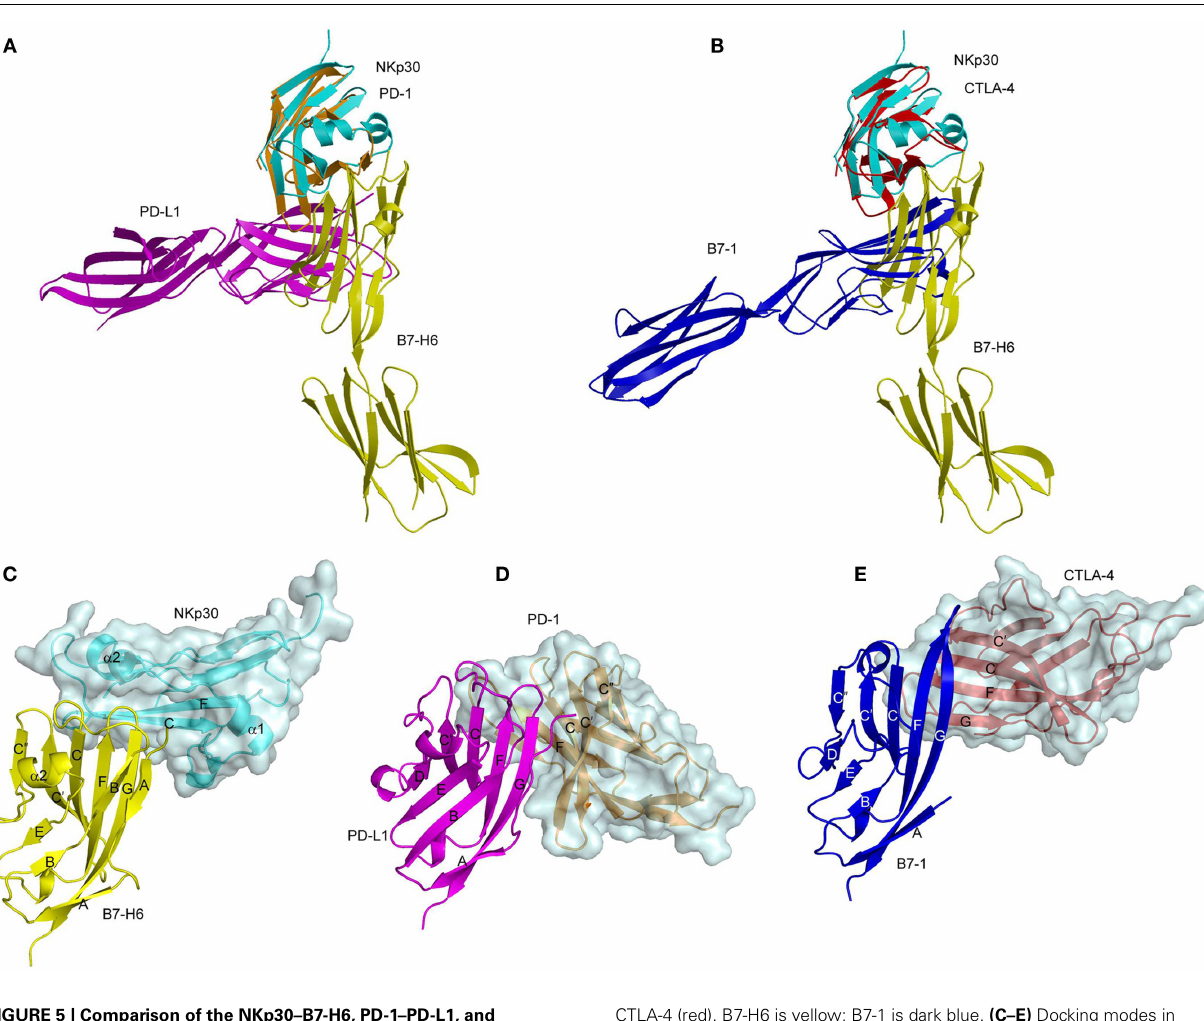
CTLA-4 (red). B7-H6 is yellow; B7-1 is dark blue. (C–E) Docking modes in the NKp30–B7-H6, PD-1–PD-L1, and CTLA-4–B7-1 complexes.The three complexes were overlaid by superposing the IgV domains of B7-H6 (yellow), PD-1-L1 (violet), and B7-1 (dark blue), then translated horizontally for